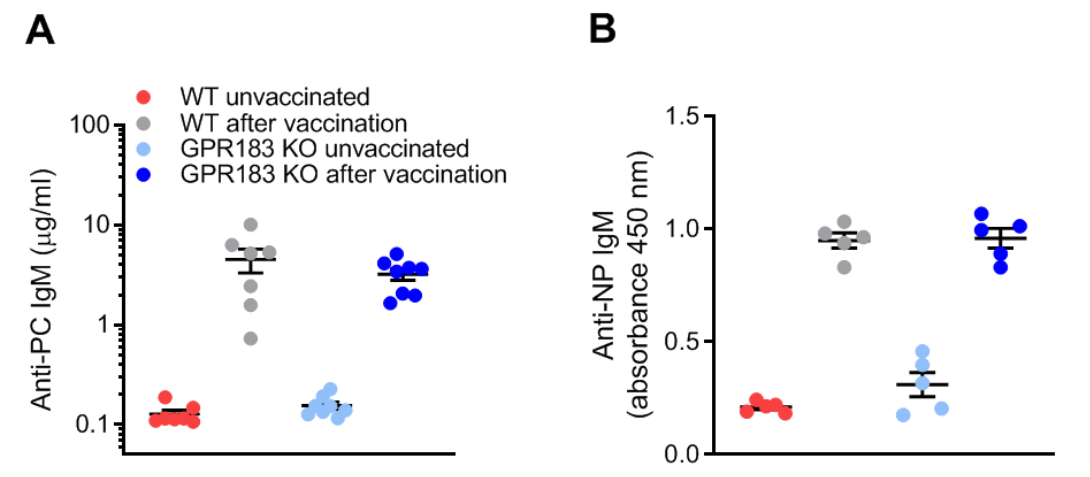
Figure 7. B1 cell antibody responses in GPR183 KO mice; ( A ) GPR183 KO and WT mice were vaccinated i.p. with 10 7 inactivated S. pneumoniae bacteria. Serum phosphorylcholine (PC)-specific IgM levels were determined before and 5 days after the vaccination by ELISA; ( B ) GPR183 KO and WT mice were vaccinated i.p. with 100 µg NP-Ficoll. Serum anti-NP IgM levels were determined before and 7 days after the vaccination by ELISA. Error bars represent mean ± SEM of data from 5–8 mice, aged 13–20 weeks.